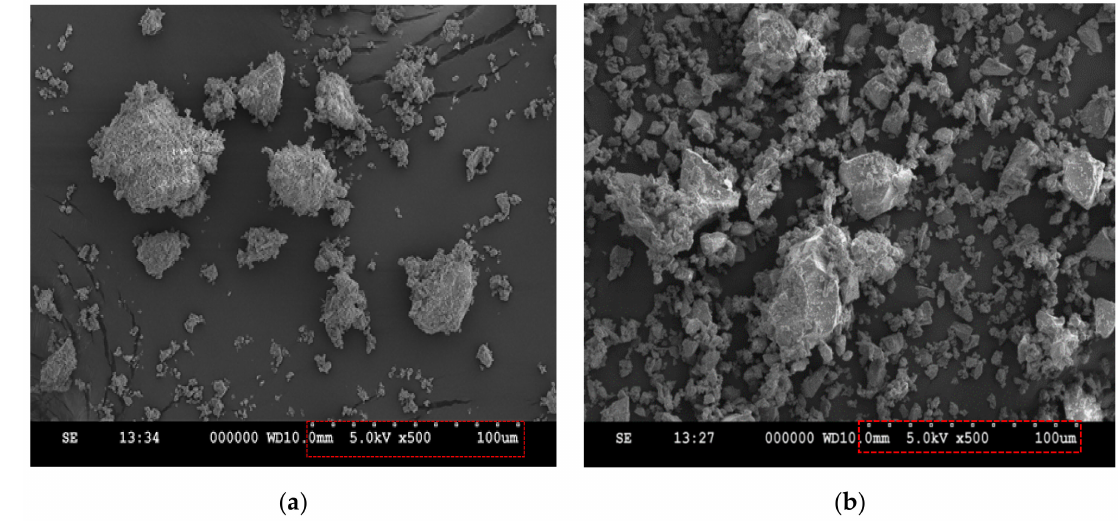
Figure 7. ( a ) CS grain morphology; ( b ) GGBS grain morphology by secondary electron